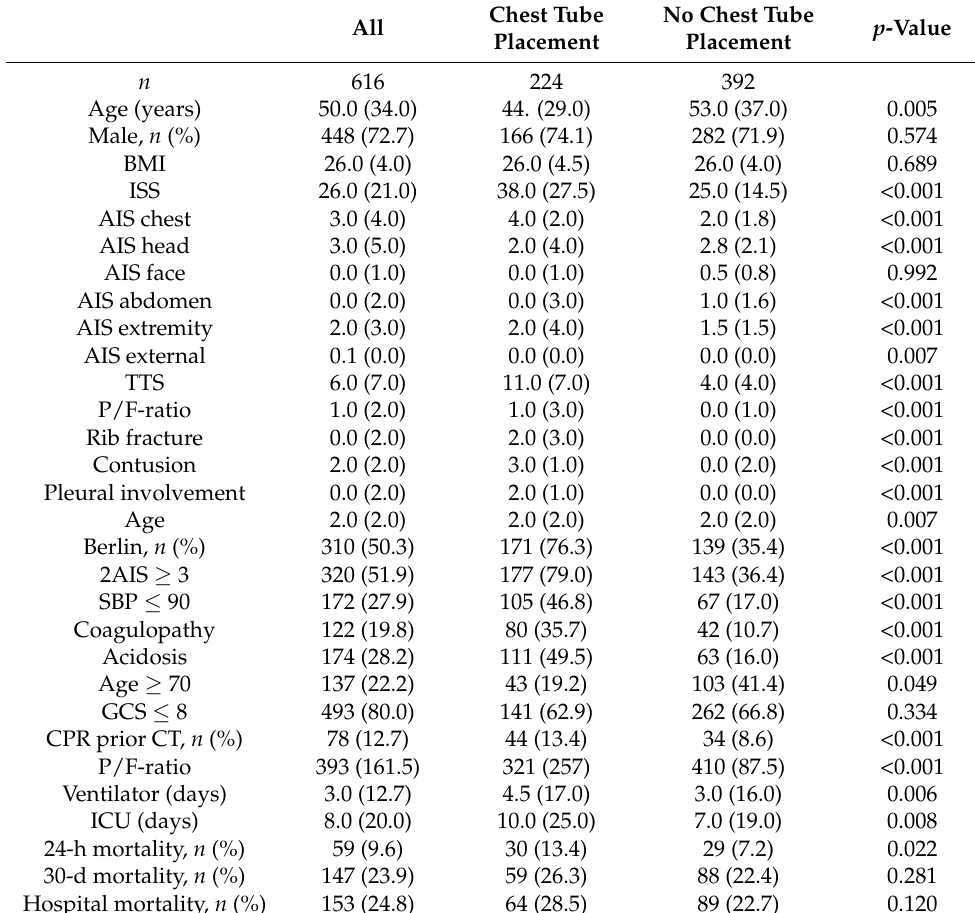
Table 1. Baseline characteristics of patients with and without chest tube